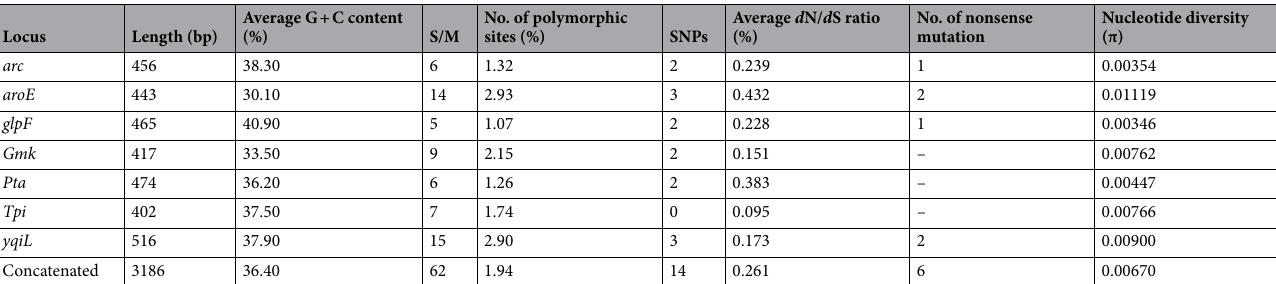
Table 2. Nucleotide and allelic sequence diversity for whole population of seven housekeeping genes of Staphylococcus aureus in multilocus sequence typing. Variable sites ( S )/mutations( M ); Number of singletons mutations ( SNPs ); Nucleotide diversity, Pi ( π ); All locus contains 43 alleles.